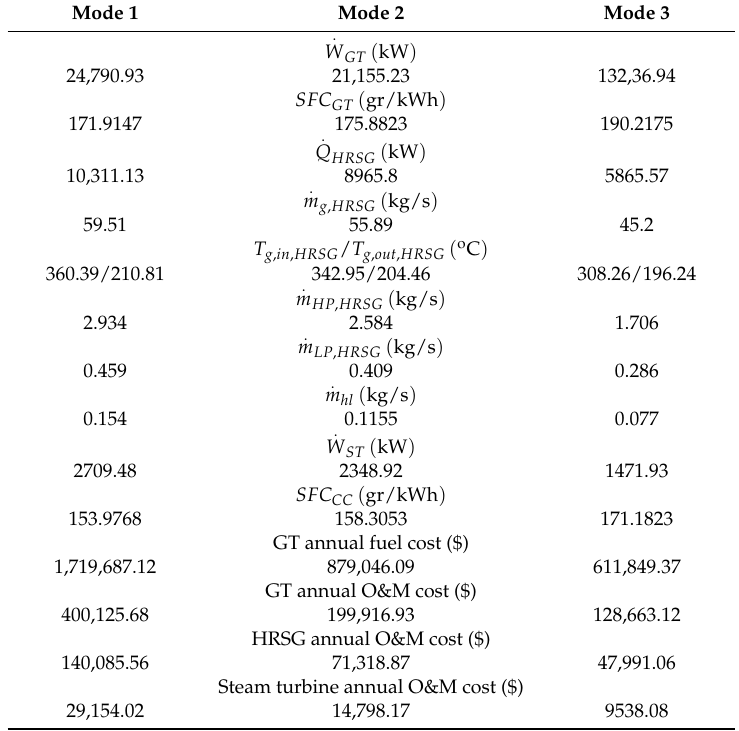
Table 12. Operational technical and economic characteristics for the system with gas turbine type (c) and fuel